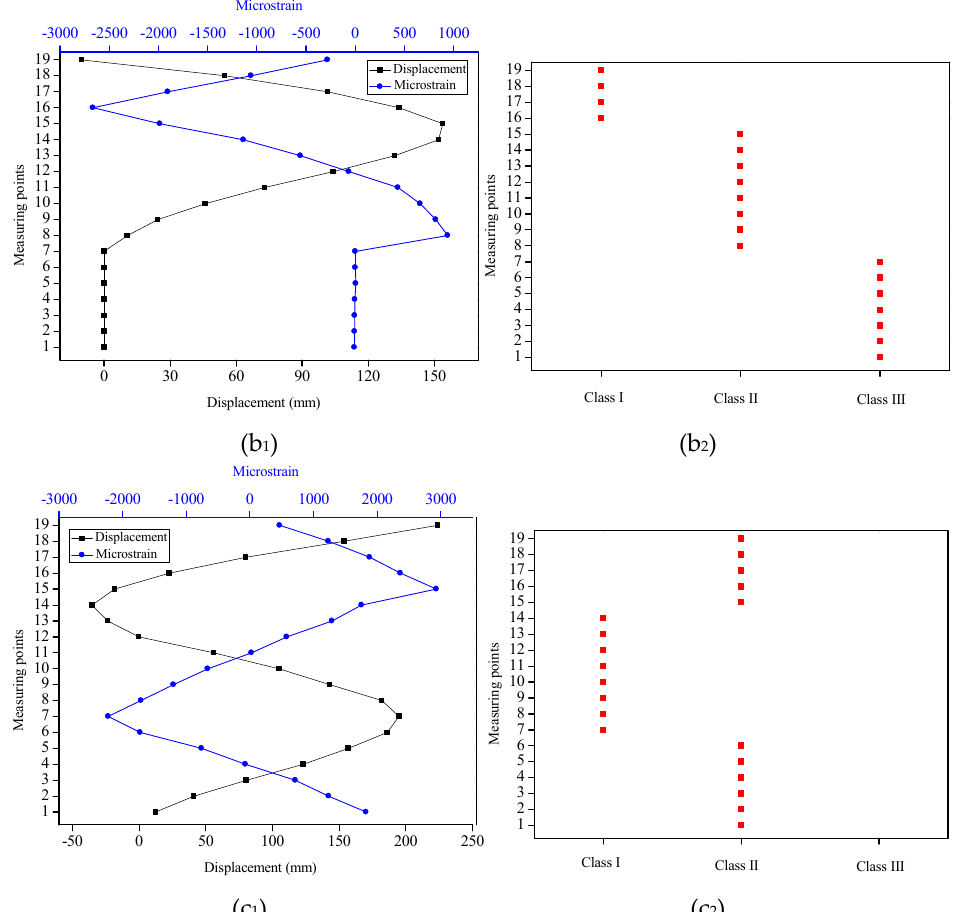
Figure 12. The displacements of the measuring points and micro-strains of the sensing points for three types and the clustering results. ( a 1 ), ( b 1 ) and ( c 1 ) represented the displacements and strains for Type 1, Type 2 and Type 3, respectively. ( a 2 ), ( b 2 ) and ( c 2 ) represented the clustering results for Type 1, Type 2 and Type 3, respectively.